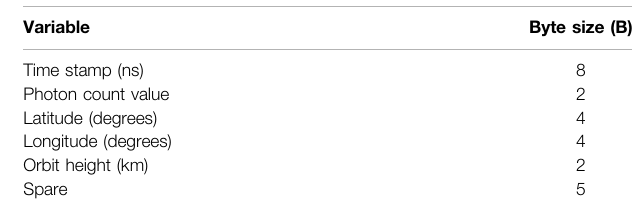
TABLE 2 | Data point